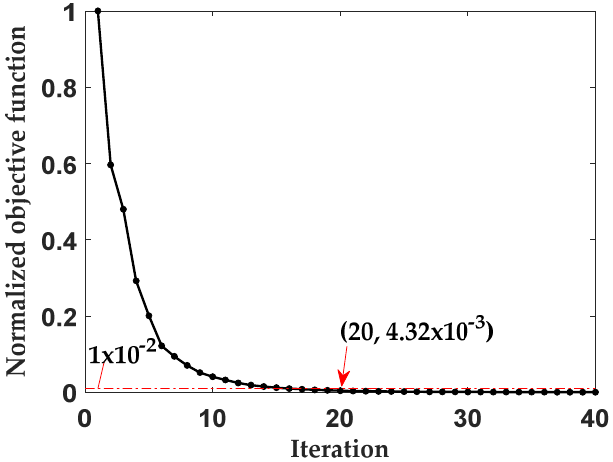
Figure 7. The evolution of the objective function with the number of iterations.